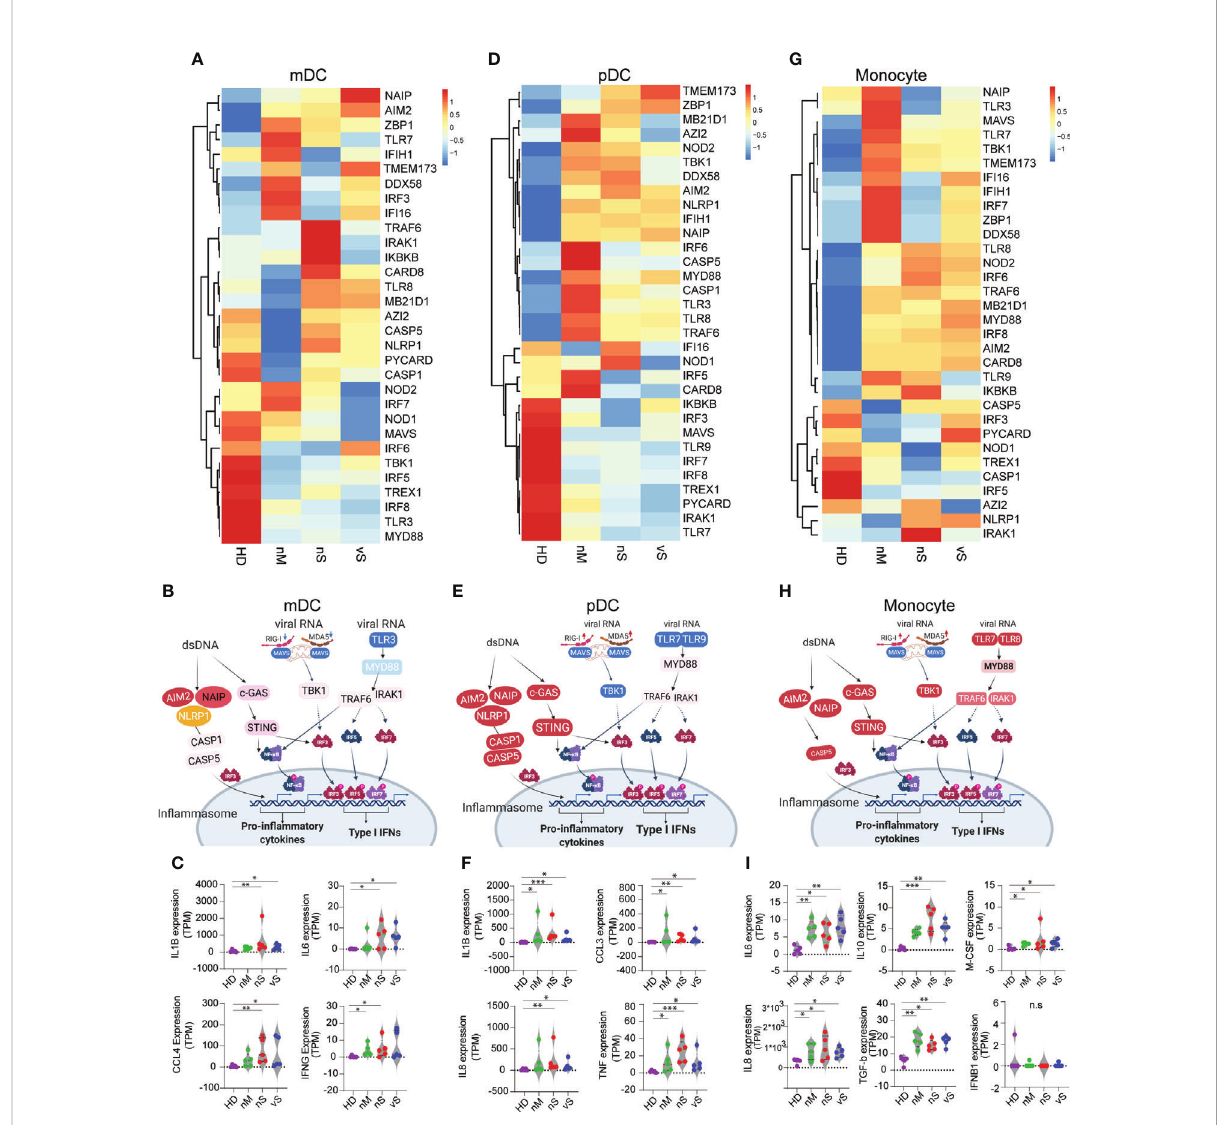
FIGURE 5 SARS-CoV-2 Infection lead to a shift in immune sensing toward proin fl ammatory cytokines and impaired type I interferon pathways. (A, D, G) . heatmaps showing RNA expression levels of DNA and RNA sensor genes in HD, nM, nS, and vS conditions in mDC (A) , pDC (D) , and Monocytes (G) . (B, E, H) . Graphic illustration of key molecule expression changes related to healthy controls in DNA/RNA sensing pathways. Red and blue indicated gene expression to be up- or -downregulated, respectively. Data from mDC (B) , pDC (E) and Monocytes (H) are shown. (C, F, I) .Signi fi cant differentially expressed downstream effector molecules of proin fl ammatory cytokines or type I Interferon are listed. mDC (IL1B, IL6, CCL4, and IFNG) (C) ; pDC (IL1B, CCL3, IL8, and TNF) (F) ; Monocytes (IL6, IL10, M-CSF, IL8, TGF-b, and IFNB1) (I) . A p-value was calculated by the Kruskal-Wallis test. *: p < 0.05, **: p < 0.01, n.s., not signi fi